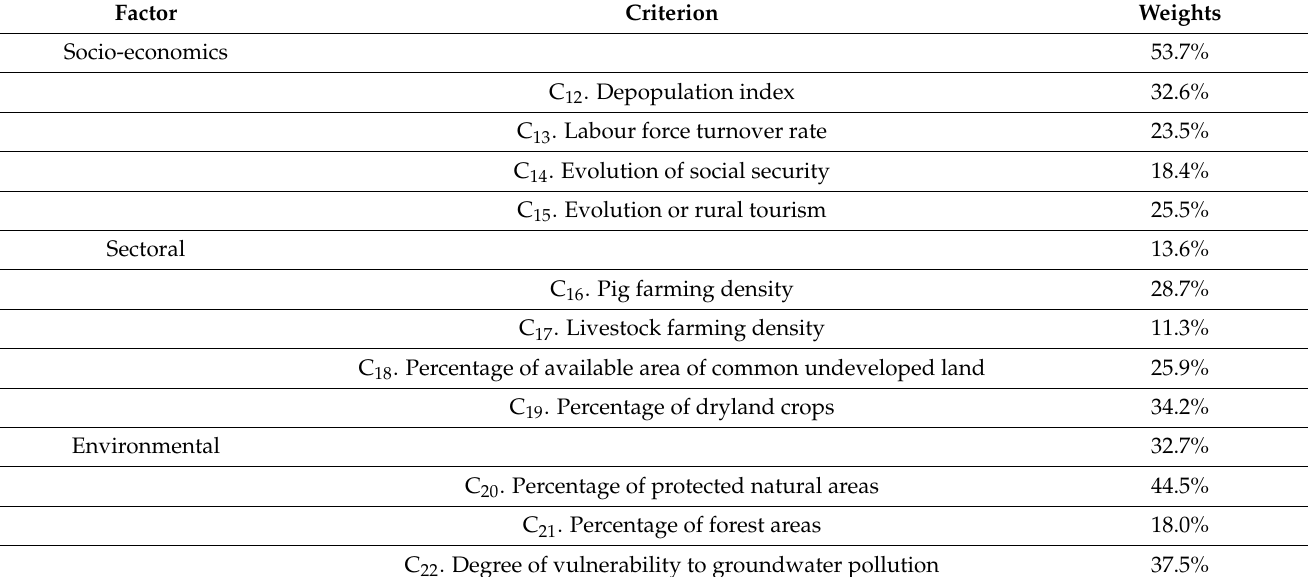
Table 7. The aggregated weights from experts’ judgements by AHP for factors and criterion. Factor